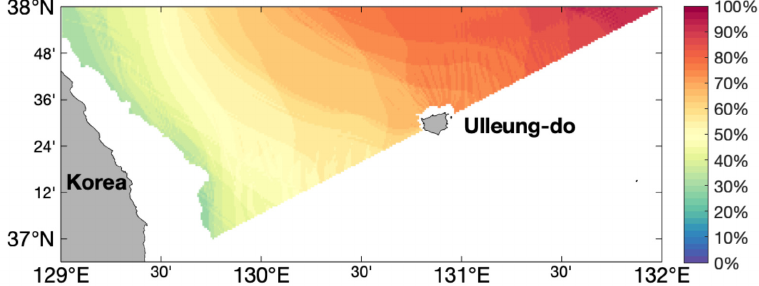
Figure 9. The probability of tsunami travel time that is less than 1.5 h after the earthquake using 39 potential tsunami